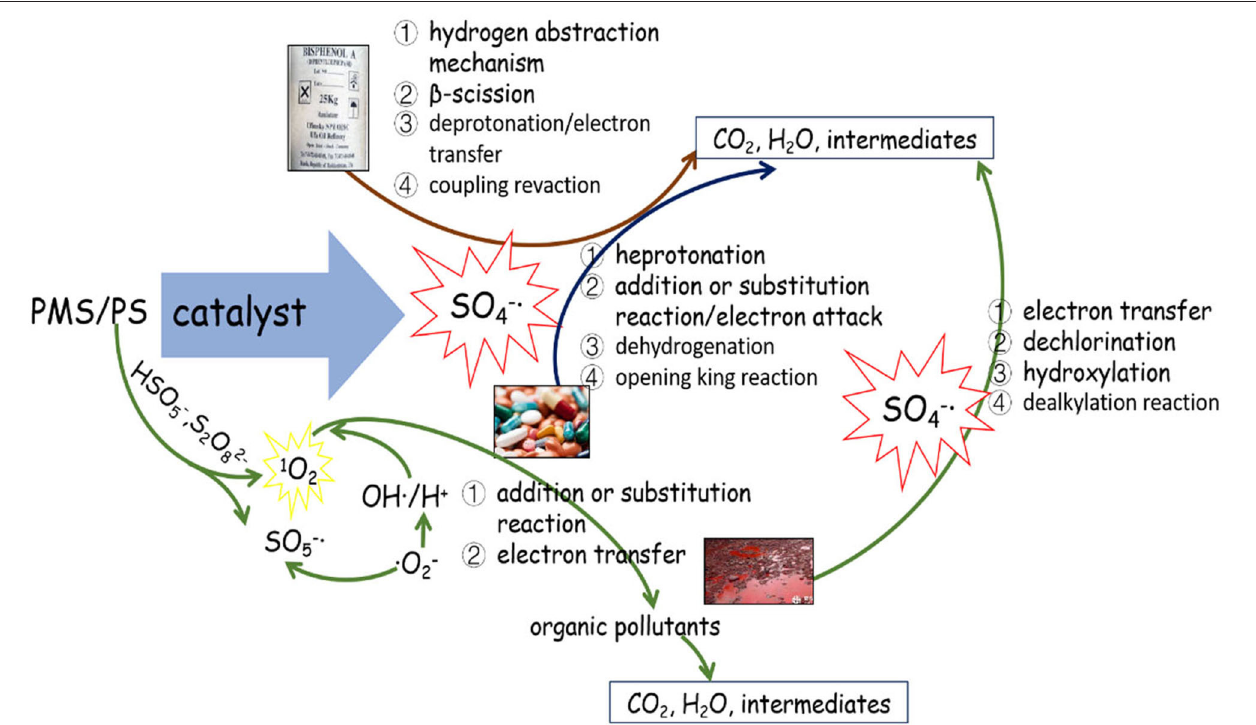
FIGURE 3 | The possible mechanism of PS/PMS